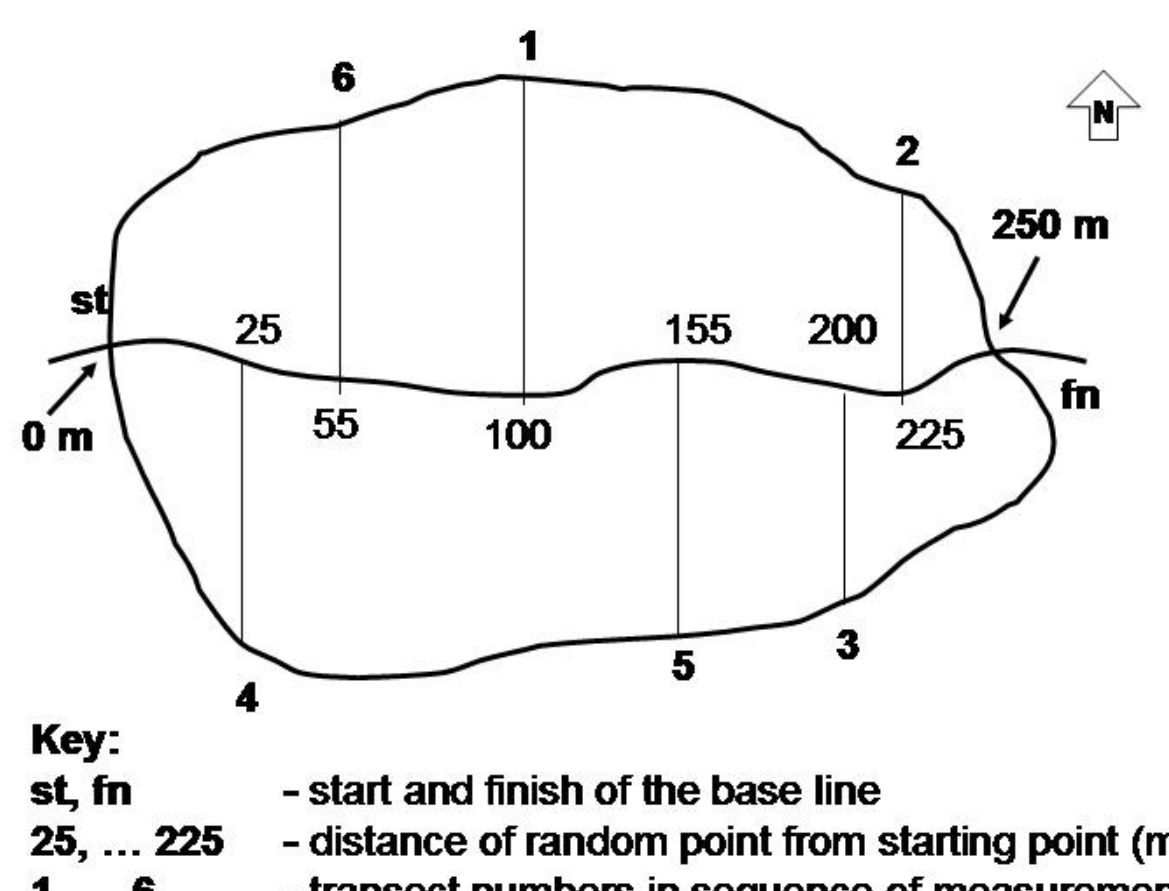
Fig. 3. A schematic diagram of a representative sampling site in Kodagu, Western Ghats, India: a base line runs across the patch and the framework of transects is placed at random points along the baseline, on a randomly chosen